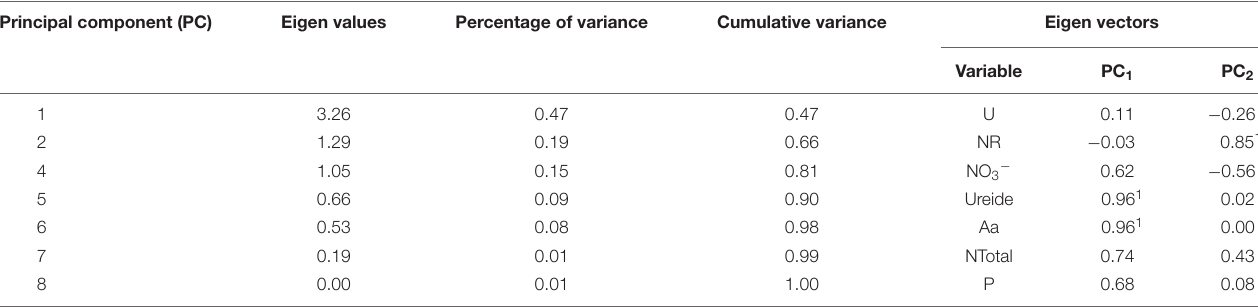
TABLE 2 | Eigen values, percentage of variance, cumulative variance, eigen vectors for different principal components. Principal component